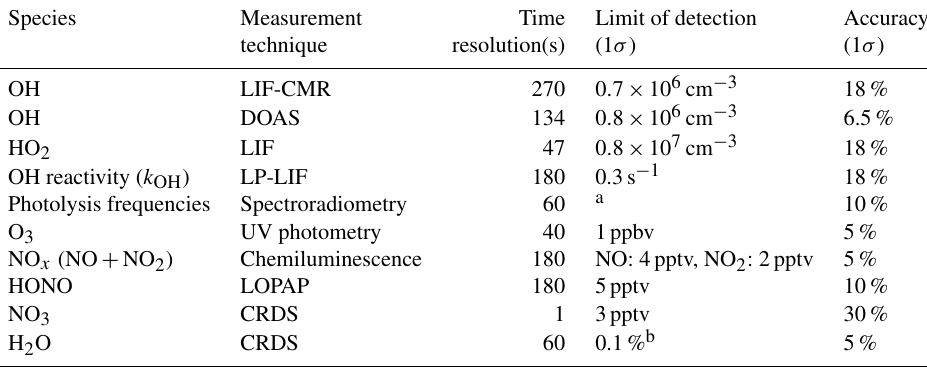
Table 2. Specification of instruments used at SAPHIR in this study. Species